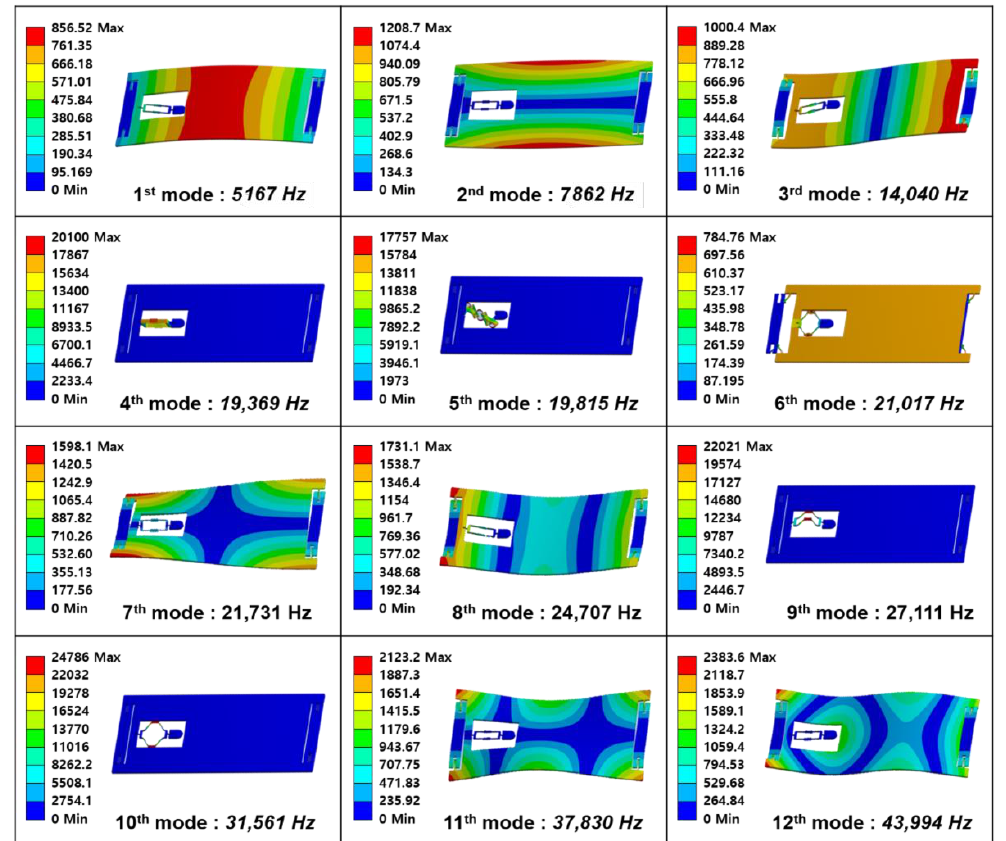
Figure 4. Modal analysis of the structure of the MEMS IMU on the frequency range of about 5~40 kHz that corresponds to the operating environment.